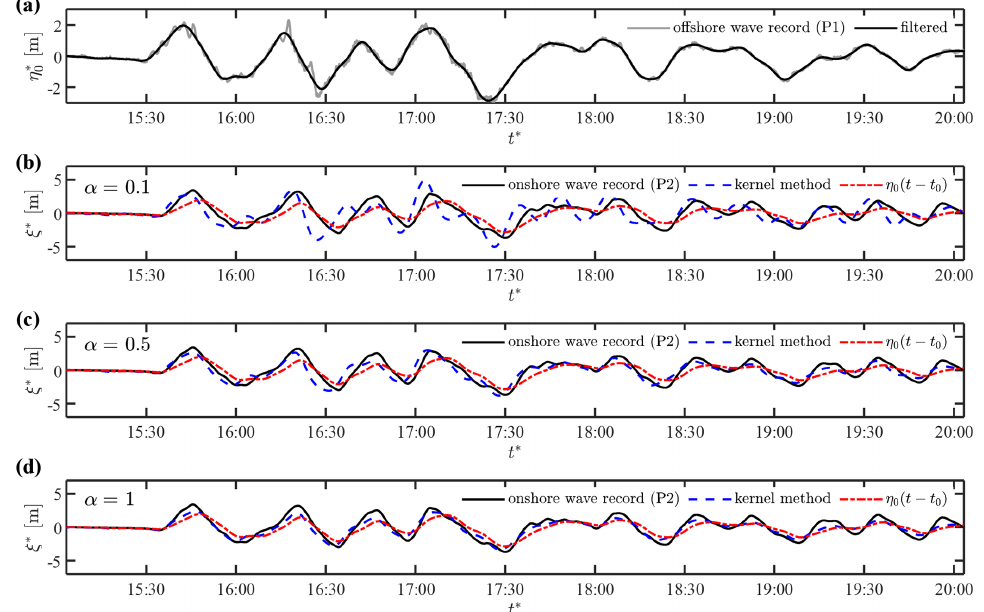
Figure 8. Prediction of the shoreline motions in Case 1: (a) observed and low-pass-filtered wave data at P1 and (b–d) waveforms at the shoreline computed with α = 0 . 1, α = 0 . 5 and α = 1 . 0, respectively, in comparison to the coastal wave record at